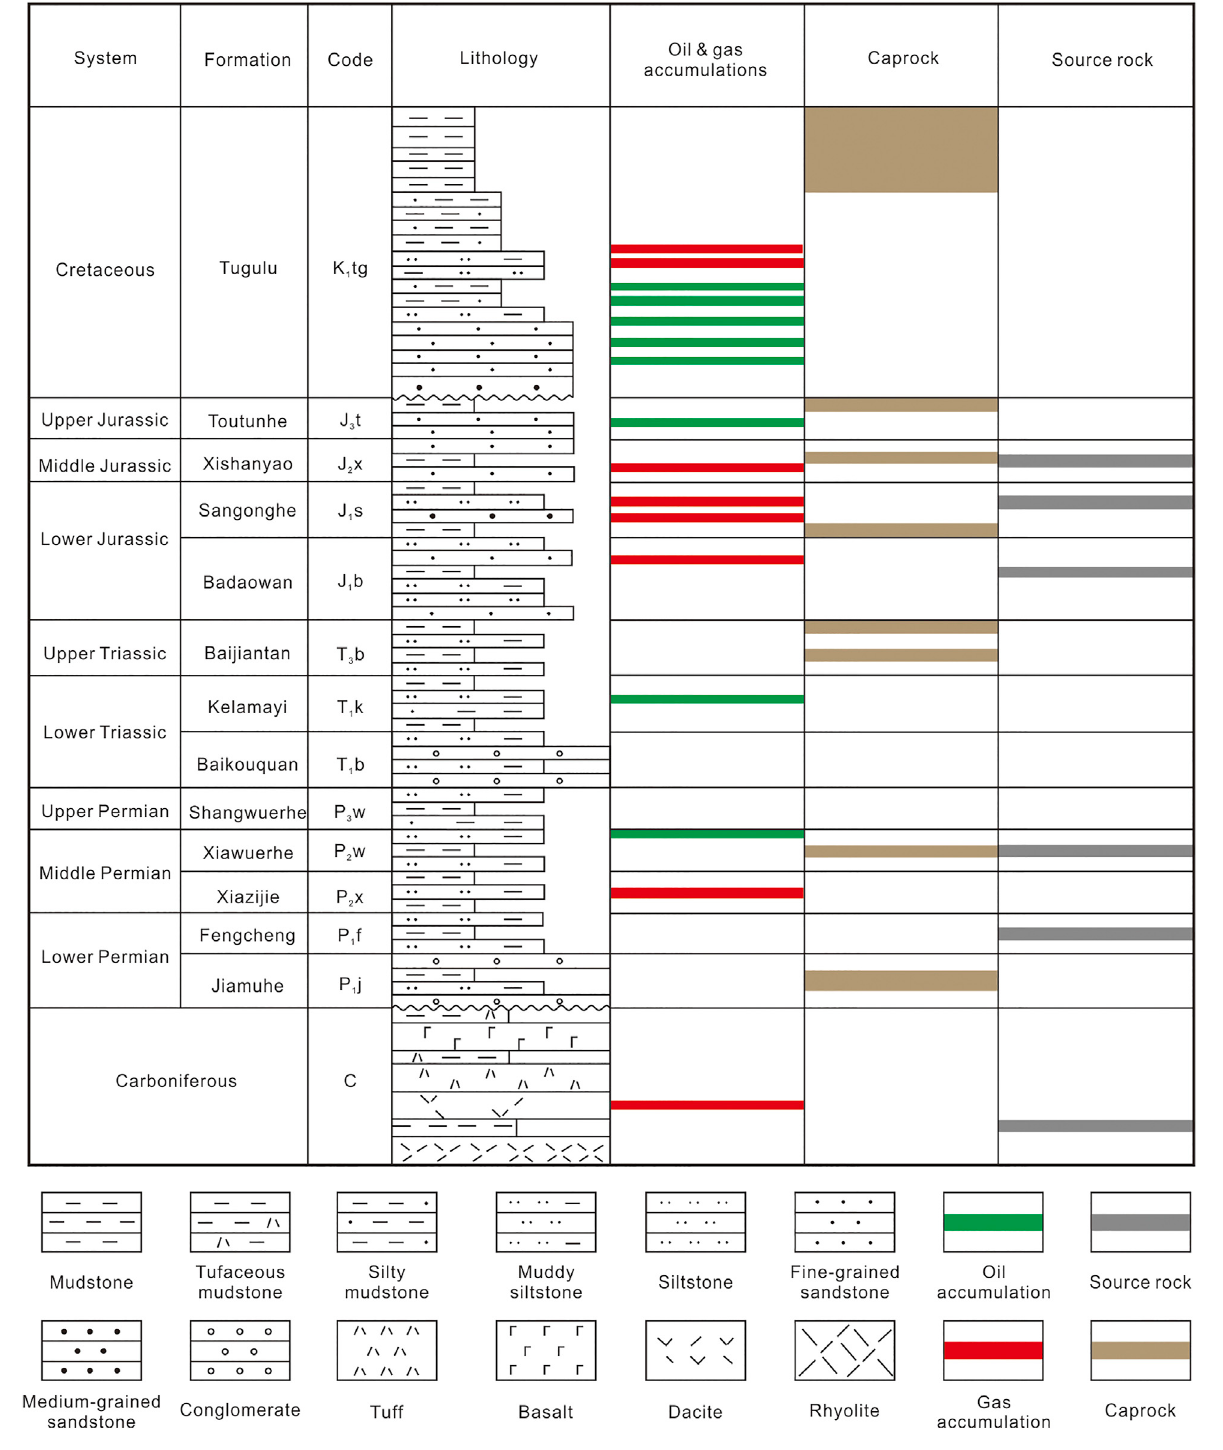
Frontiers in Earth Science |